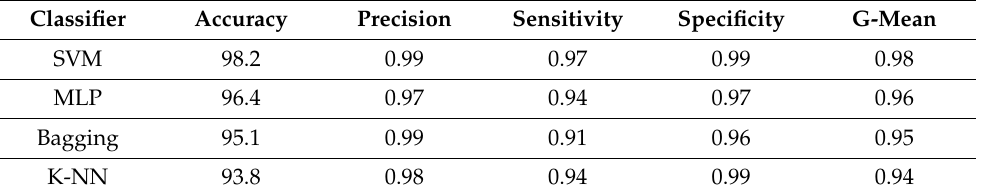
Table 5. Evaluation results based on the RFE + PCA models.